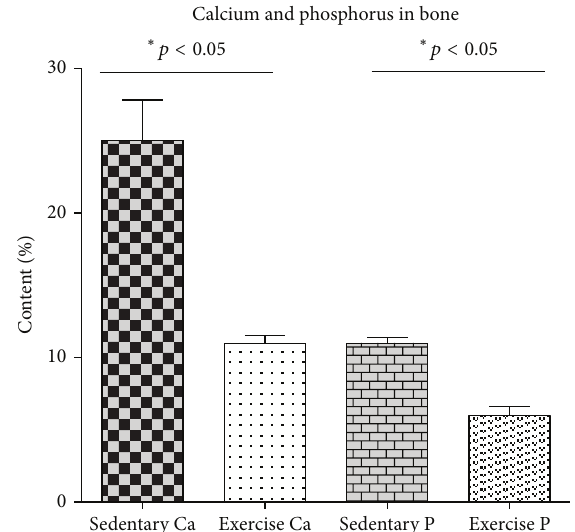
Figure 4: The concentration of calcium and phosphorus in the bone after endurance exercise training. Statistical significance ( 𝑝 < 0.05